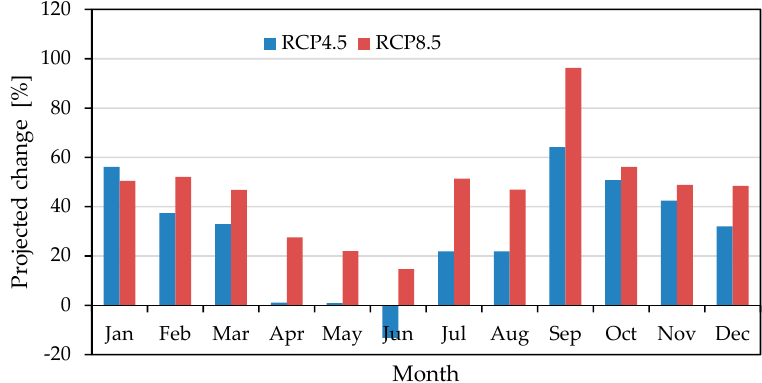
Figure 10. Change in projected monthly discharge under climate scenarios RCP4.5 and RCP8.5.